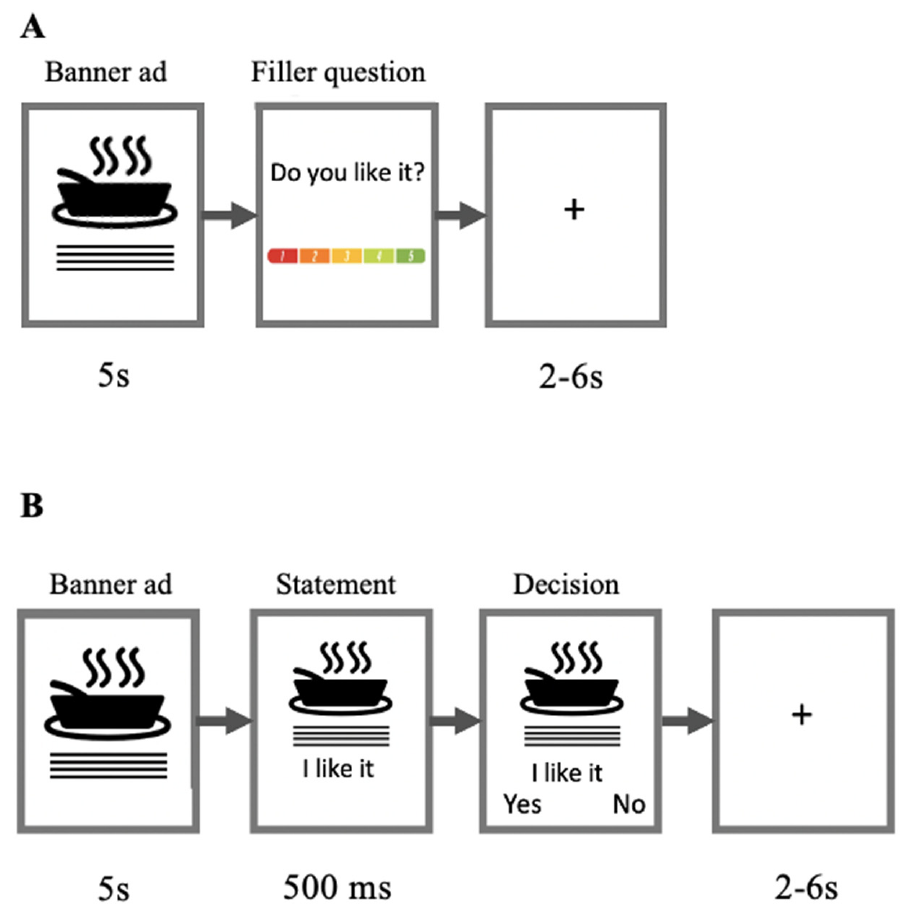
Figure 1. Experiment design: Trial structure of Study 1 ( A ) and Study 2 ( B ). During Study 1 ( A ), participants observed a banner ad (5 s) and answered a filler question. At the end of the trial, the Figure 1 . Experiment design: Trial structure of Study 1 (A) and Study 2 (B). participants rated the banners. During Study 2 ( B ), participants observed a banner ad (5 s) and statement (e.g., “I like it”) (500 ms). At the end of the trial, participants indicated whether they agreed or disagreed with the statement. In both studies, the intertrial interval (ITI) was 2–6